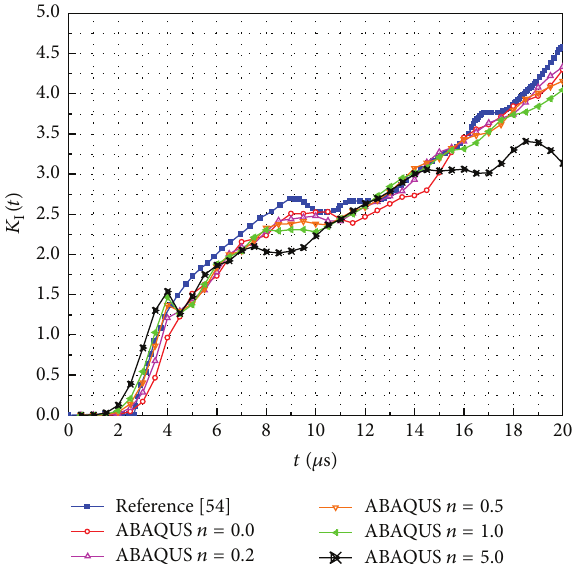
Figure 12: Dynamic stress intensity factor 𝐾 I of central-crack functionally graded plate with different shape factors.